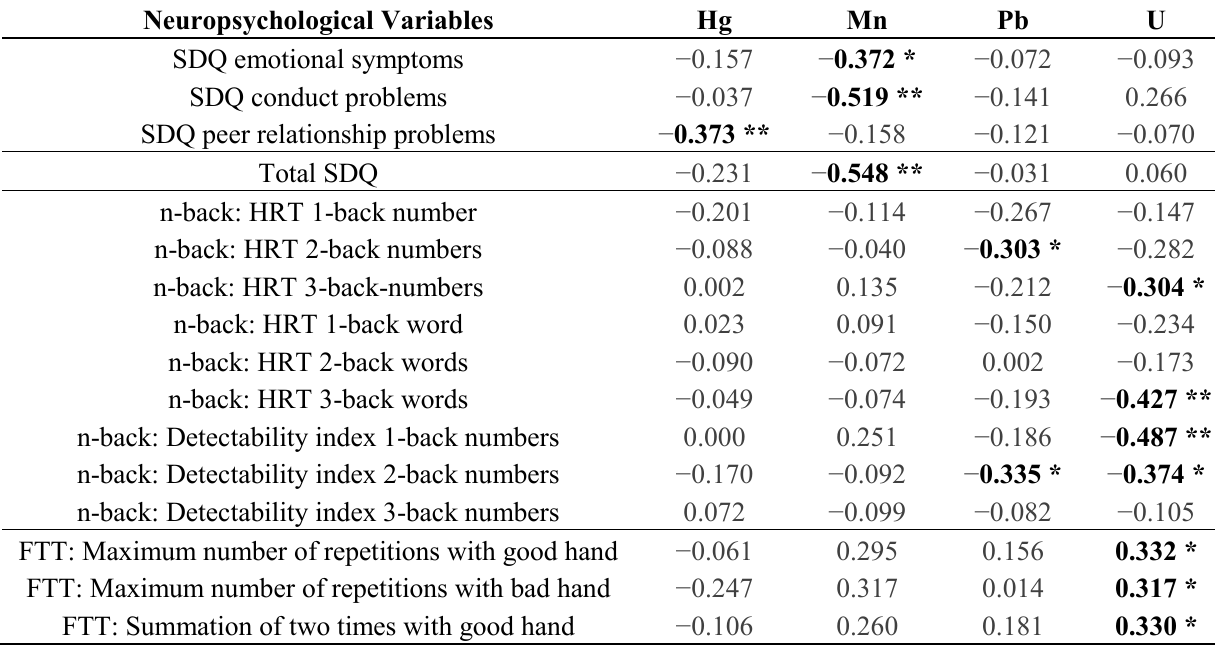
Table 3. Spearman correlations between metal levels in the hair of children (boys and girls together) and neuropsychological variables ( N = 53). SDQ, Strengths and Difficulties Questionnaire; HRT, hit reaction time; FTT, finger-tapping